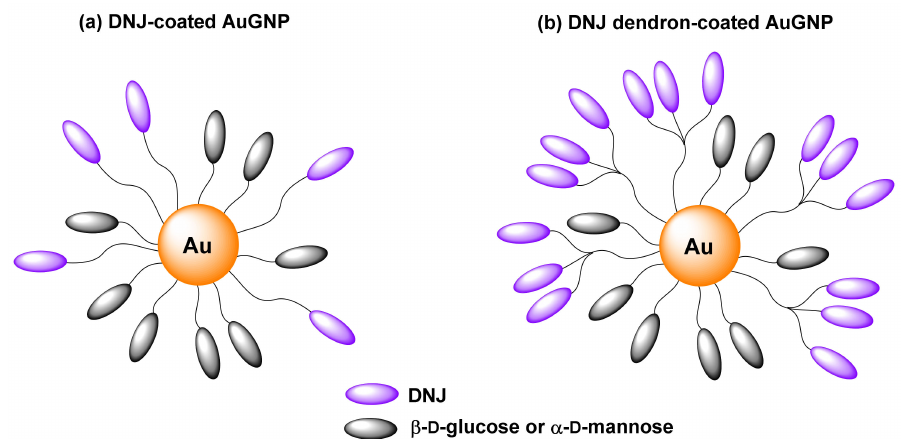
Figure 1. ( a ) Multivalent presentation of DNJ, using glyco-gold nanoparticles as scaffold and ( b ) the combination of glyco-gold nanotechnology with the iminosugar dendron approach.